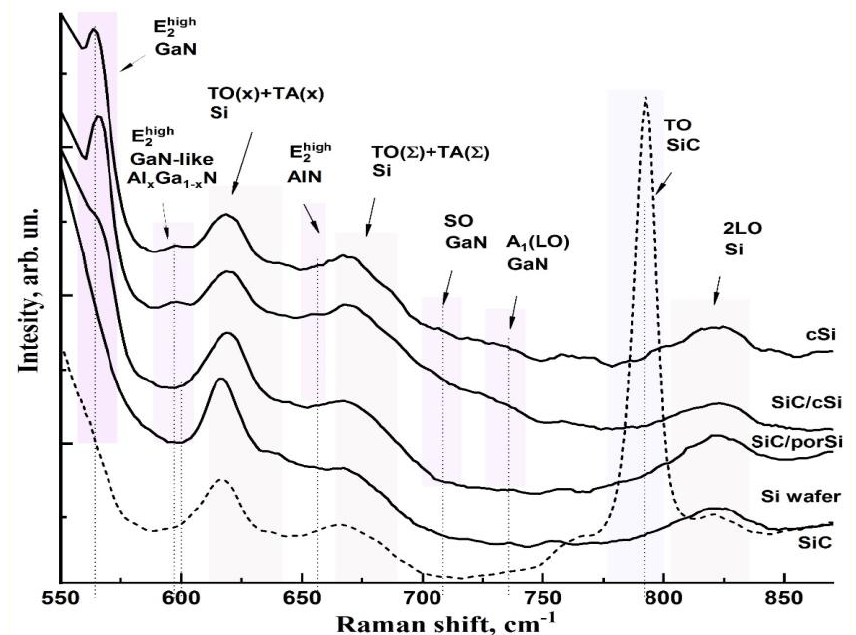
Figure 3. Region 530–900 cm − 1 in the Raman spectra of the investigated heterostructures, silicon wafer, and SiC reference.